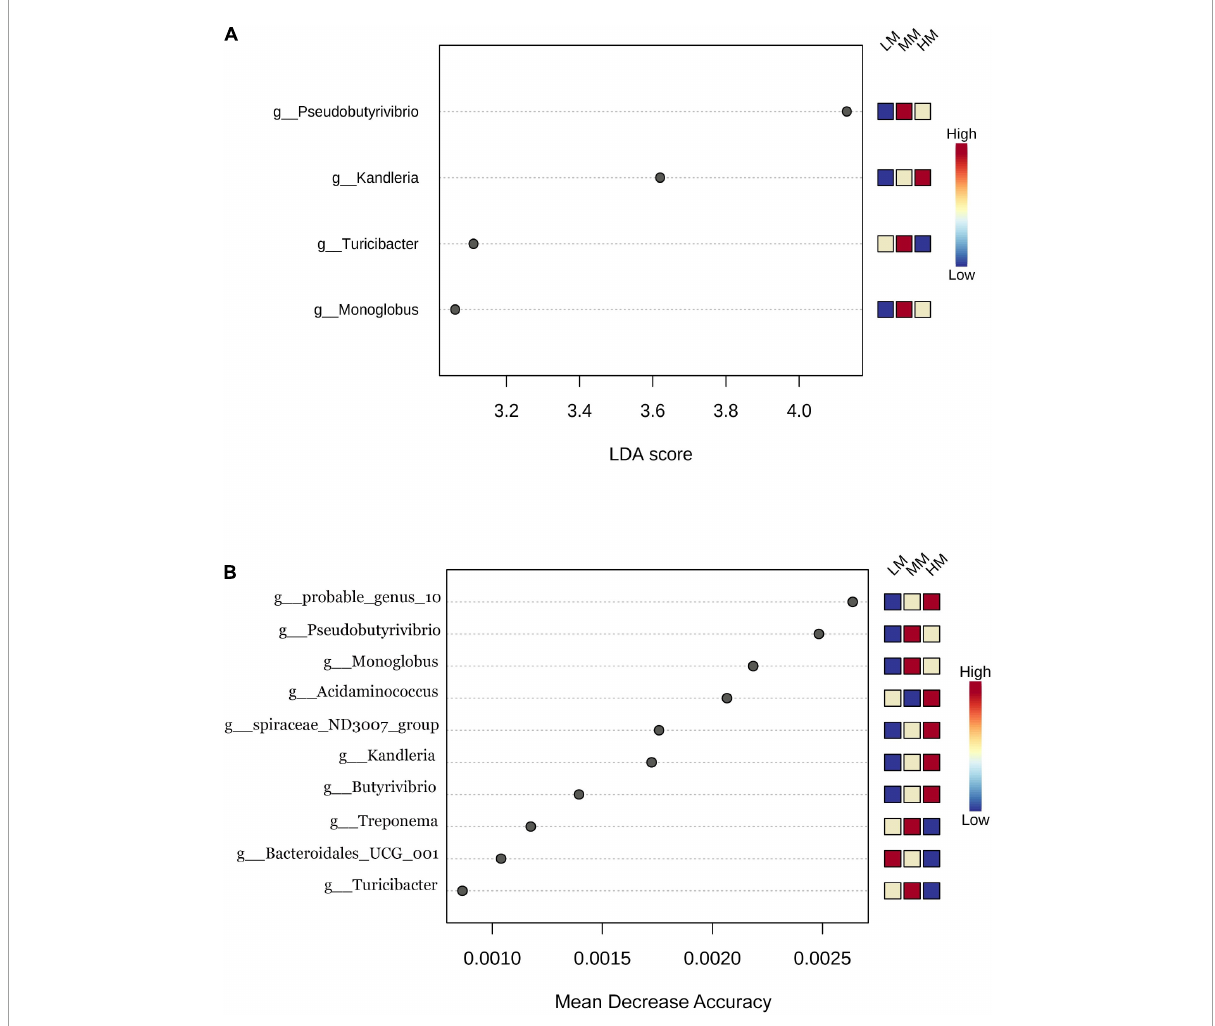
FIGURE3 Linear discriminant analysis effect size (A) ; differentially abundant bacterial taxa defined by LEfSe analysis) computed among low marbling grade (LM), middle marbling grade (MM) and high marbling grade (HM). (LDA > 2, FDR < 0.1) (B) the biomarker bacteria classes were identified by applying Random Forest regression analysis of the relative abundance of rumen